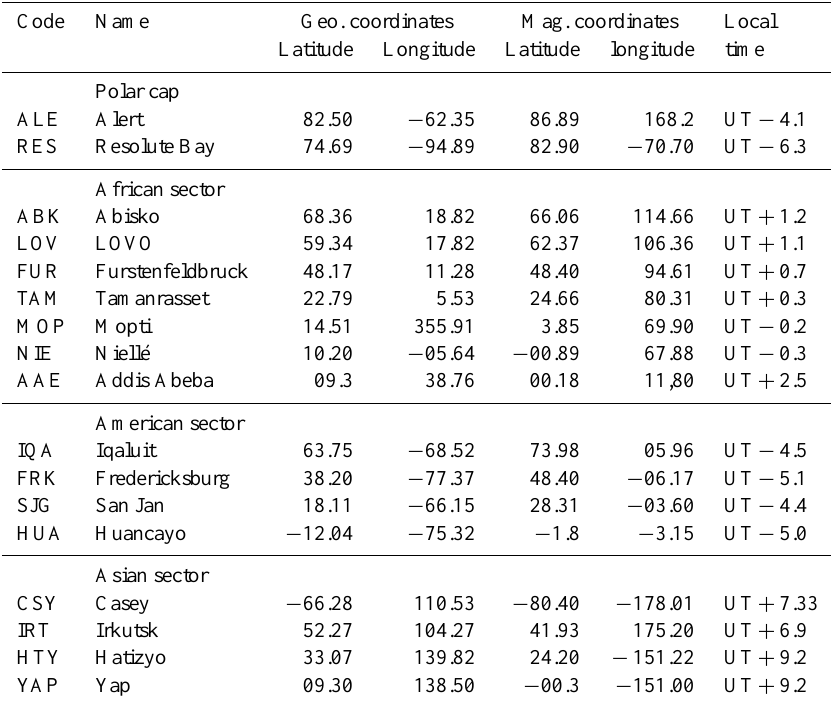
Table 1. Locations of magnetic